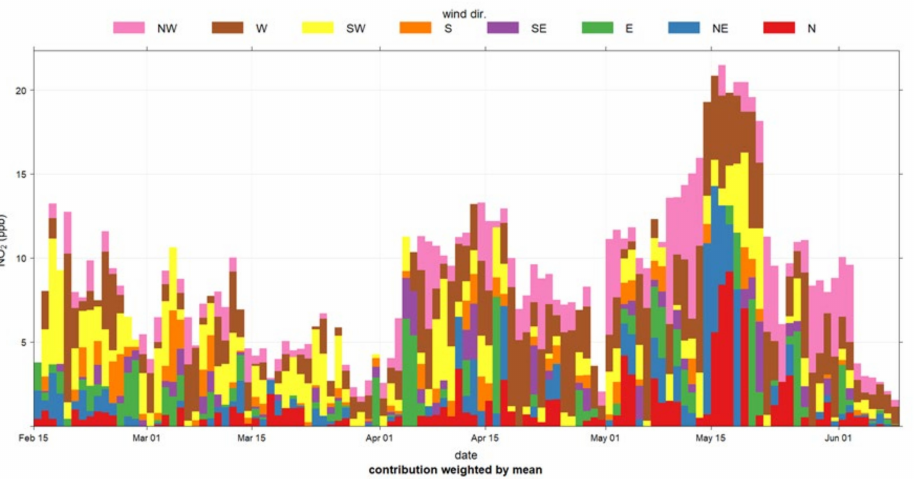
Figure 15. The time series of NO 2 concentrations categorized by wind direction in one-day stacked